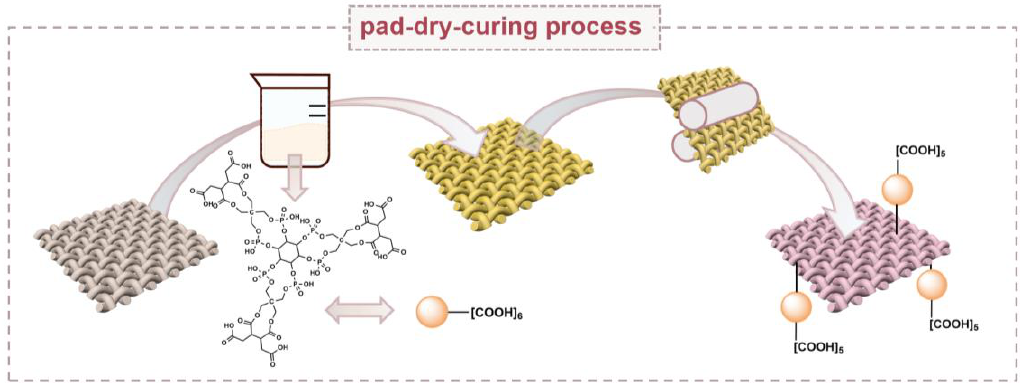
Figure 11. The preparation process of flame-retardant cotton